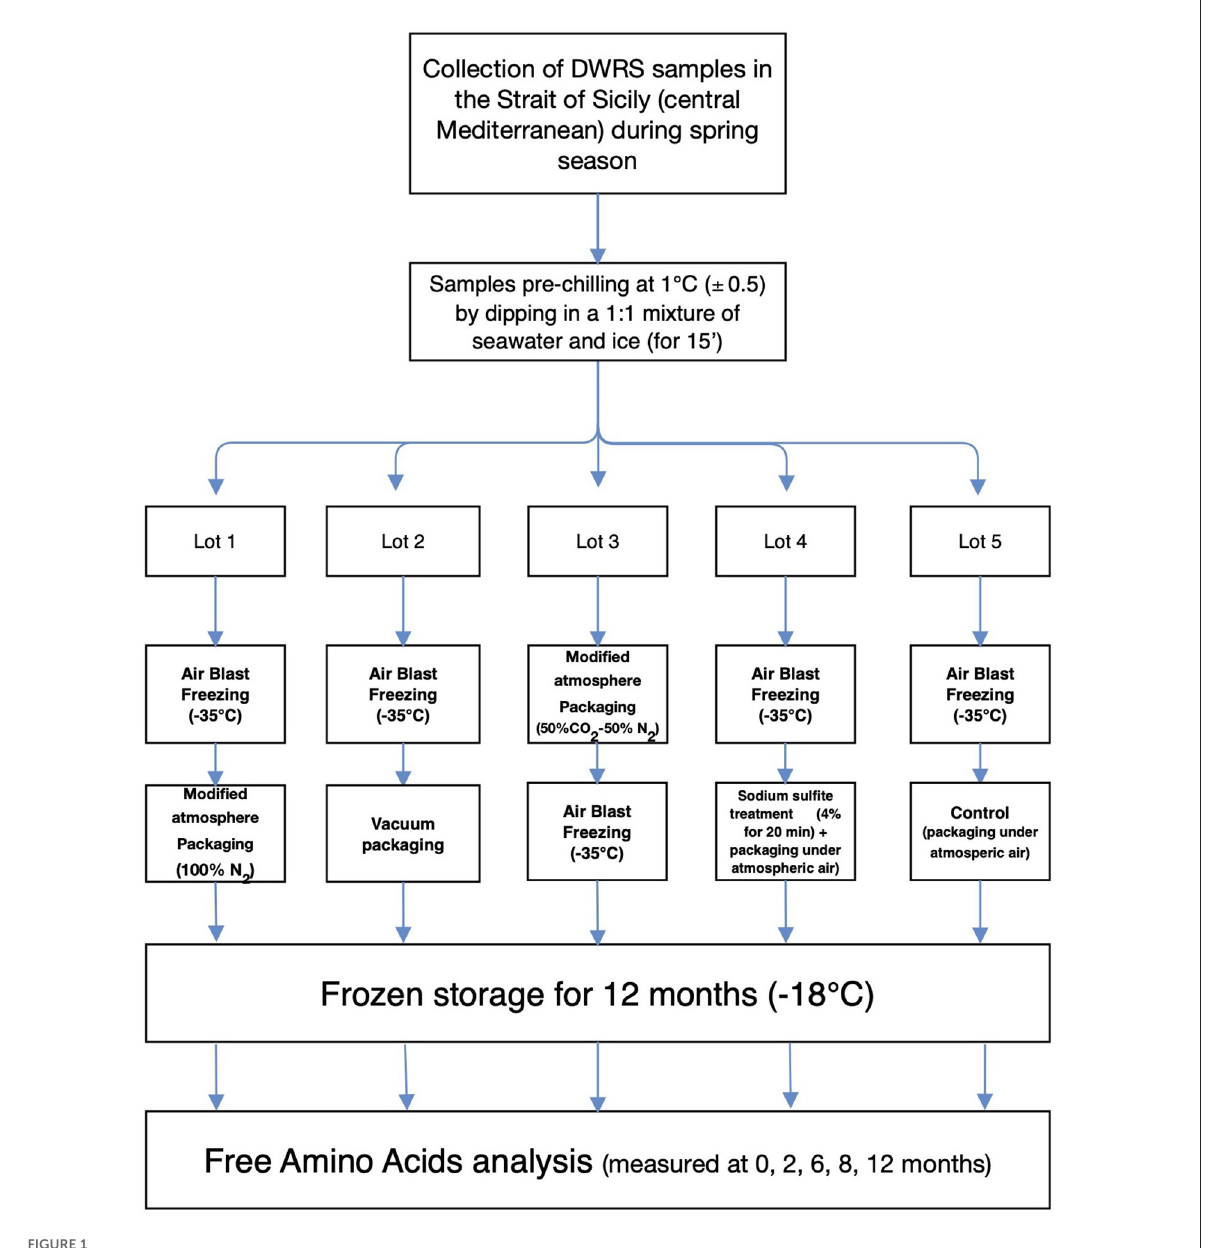
FIGURE1 Schematic representation showing an overview of the experimental program, starting from the harvesting of DWRS samples by bottom trawl vessels to the analytical determination of